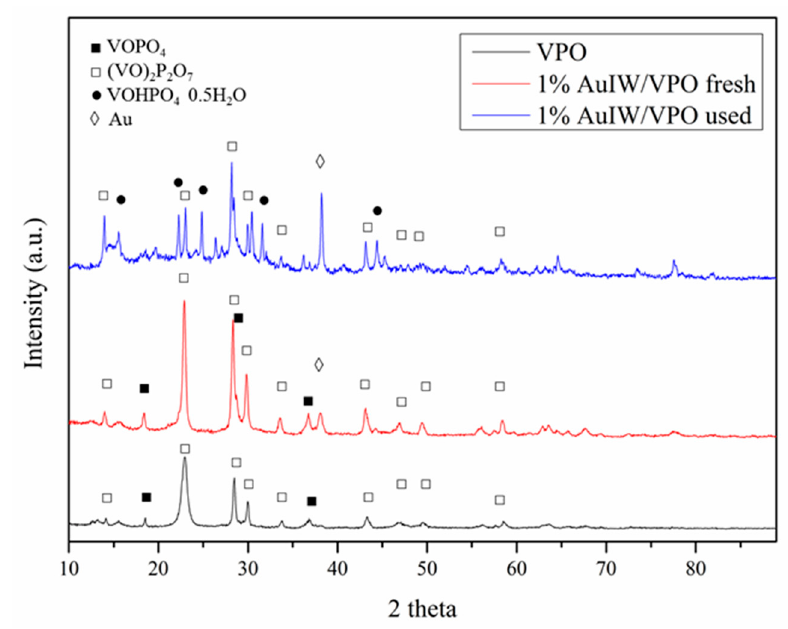
Figure 5. XRD patterns of fresh and used (after five cycles)1% Au IW /VPO catalysts.